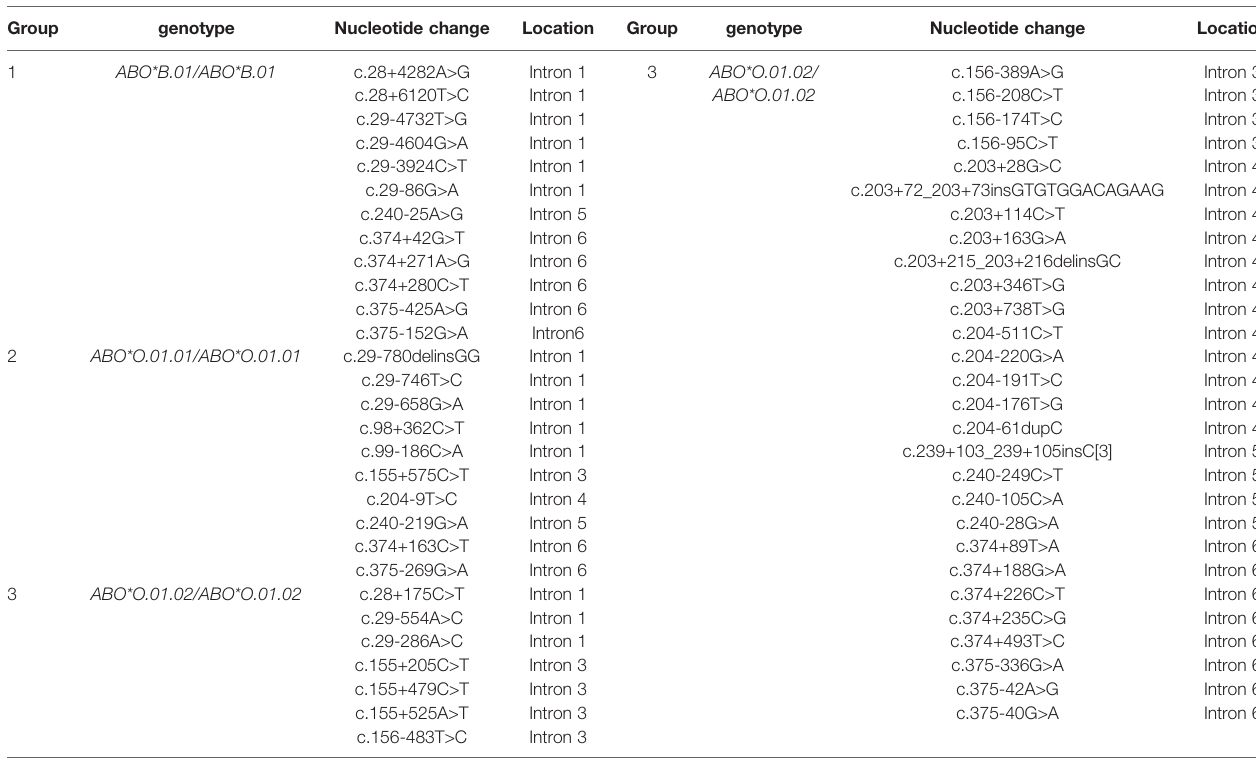
TABLE 3 | The Nucleotide change of intronic sequences for different ABO